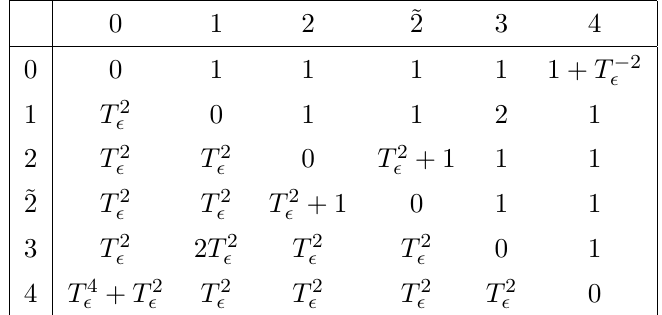
(cid:1) the factor